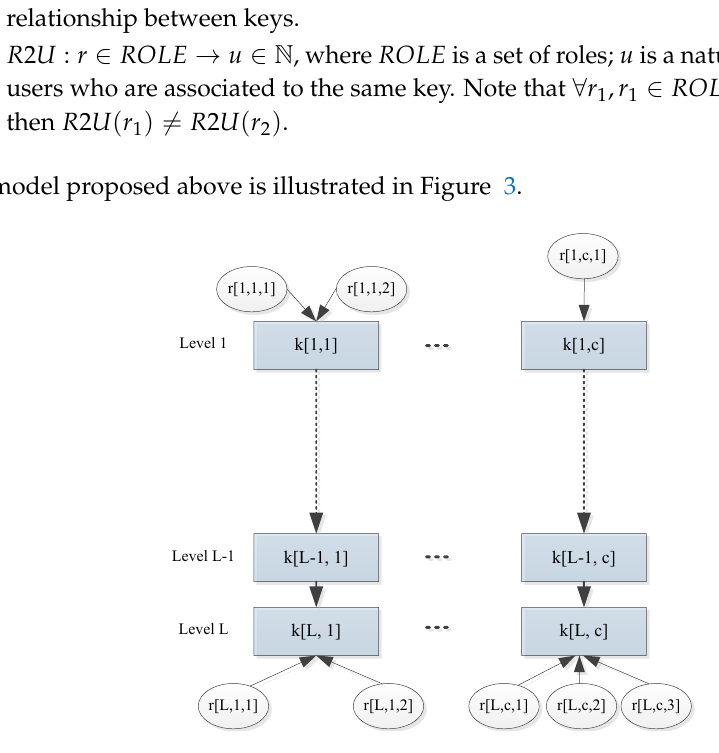
Figure 3. Hierarchical key and role